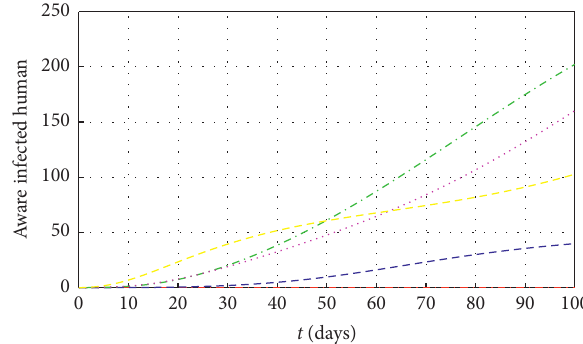
Figure 3: Population of susceptible humans with and without awareness (without awareness (red line), with low to high awareness rate (blue, green, magenta, and yellow line)).